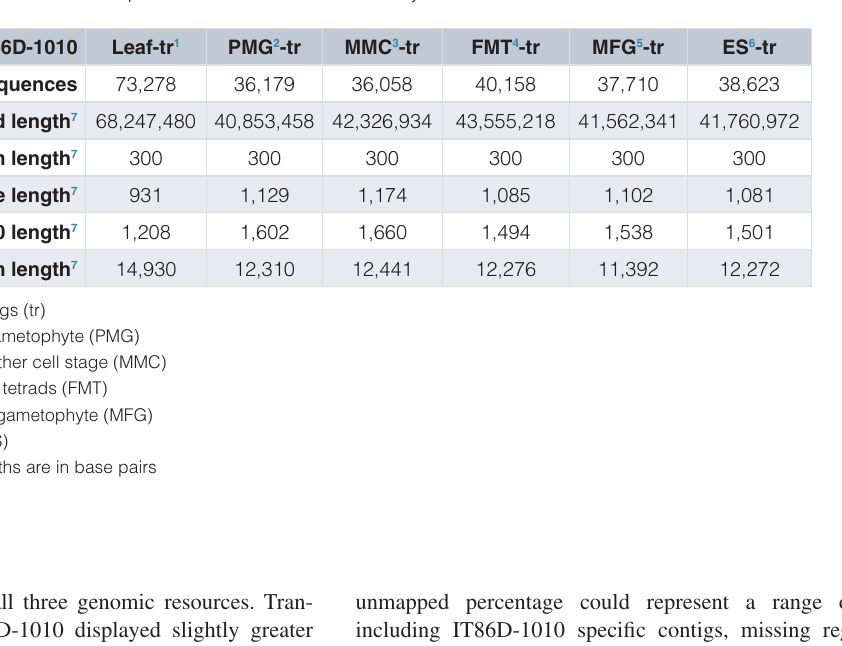
Table 5. Details of assembled tissue-specific polyA RNA sequence sets from IT86D-1010. Assembled contigs of less than 300 base pairs were excluded in this